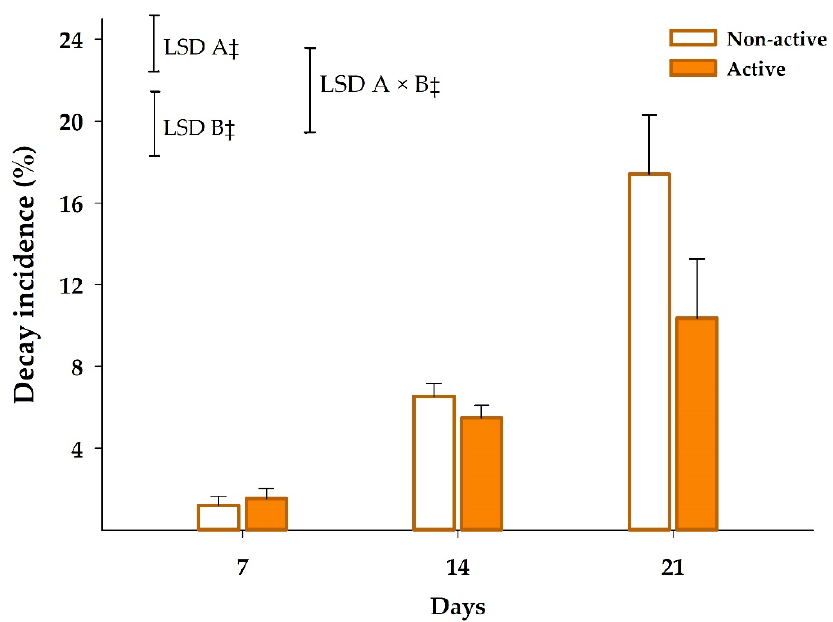
Figure 7. Decay incidence of mandarins packaged within non-active and active package up to 21 days at 8 °C ( n = 3, ± SD). Least significant differences (LSD) are represented with bars. The uppercase letters A and B denote package type and storage time, respectively. ‡ significance for p ≤ 0.001.